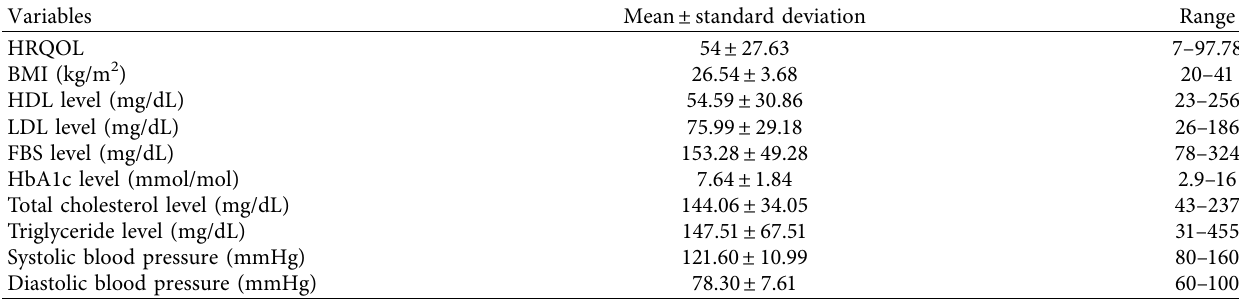
Table 2: Level of HRQOL and metabolic indicators of the participants ( N �